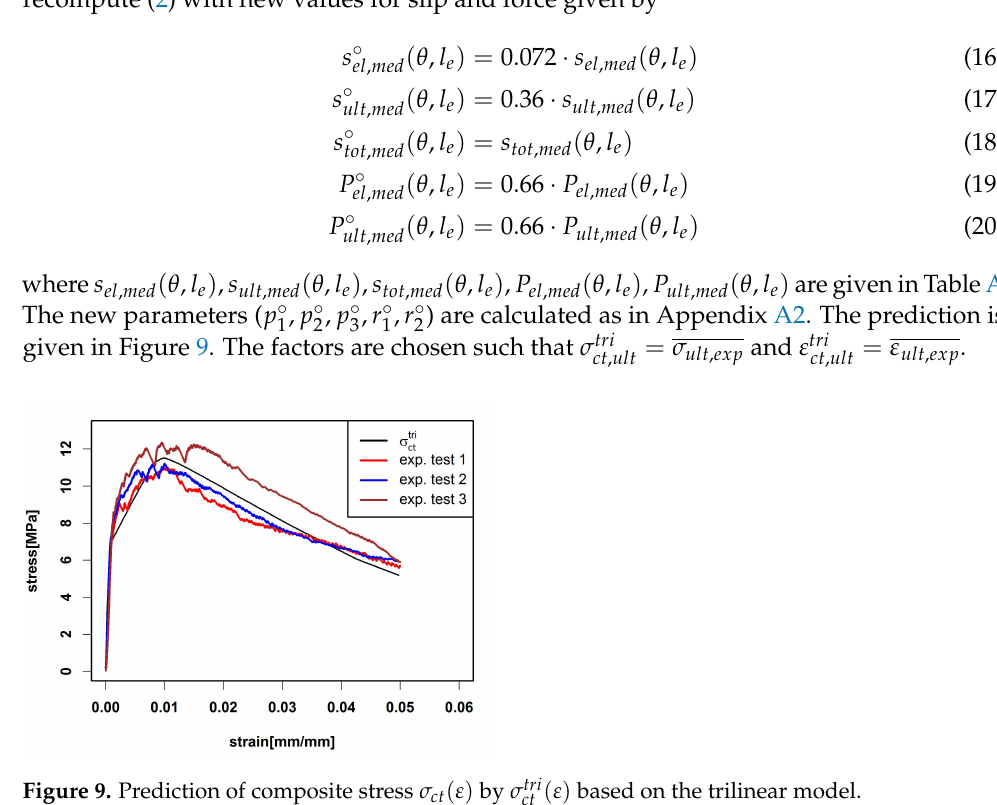
Figure 9. Prediction of composite stress σ ct ( ε ) by σ tri